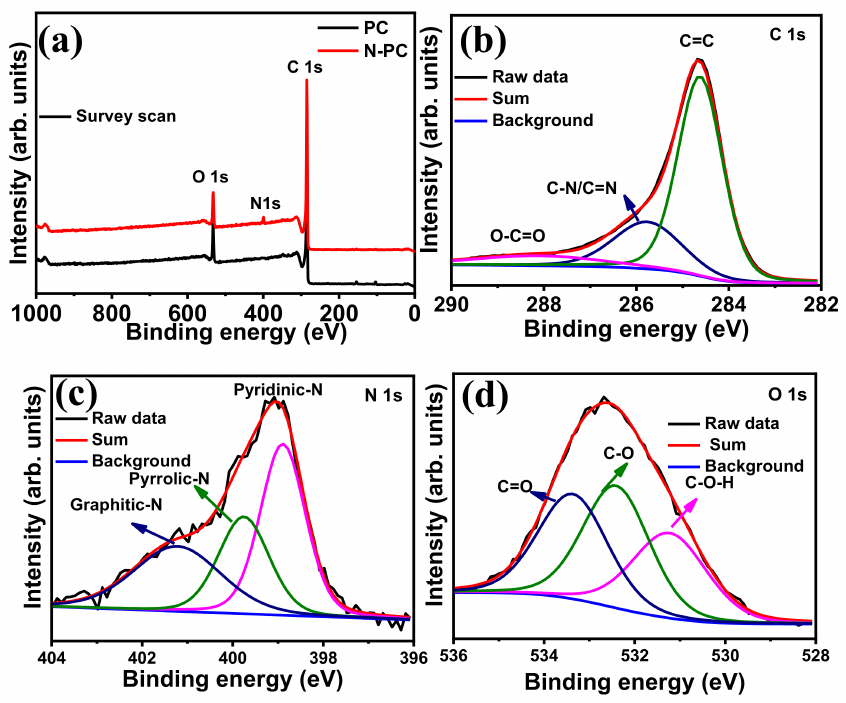
Figure 5. ( a ) XPS survey spectrum of N-PC; deconvoluted XPS spectra of ( b ) C 1s, ( c ) N 1s and ( d ) O 1s corresponding to